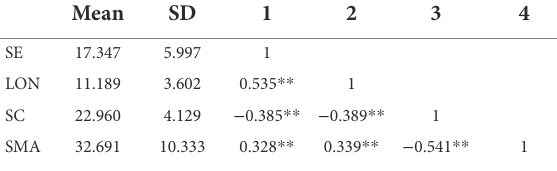
TABLE 1 Descriptive statistics and zero-order correlations of variables.